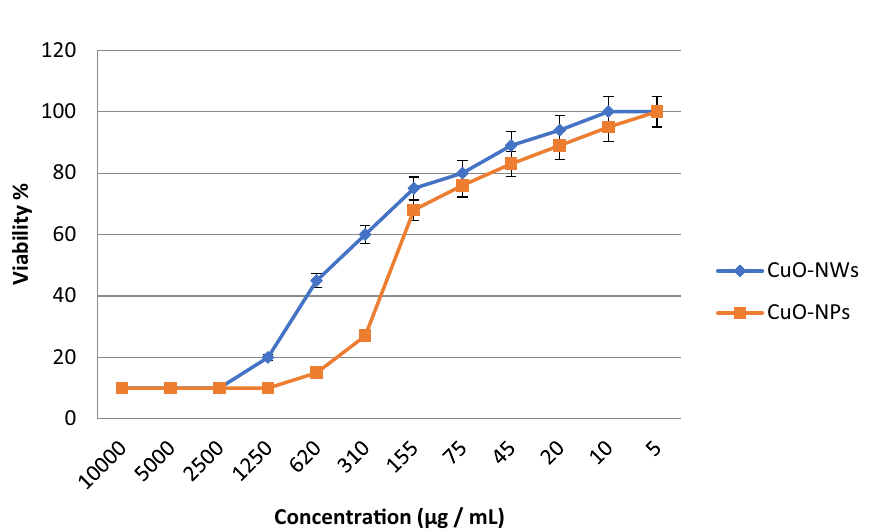
Figure 4. EDX analysis of ( a ) CuO-NWs and ( b ) CuO-NPs.